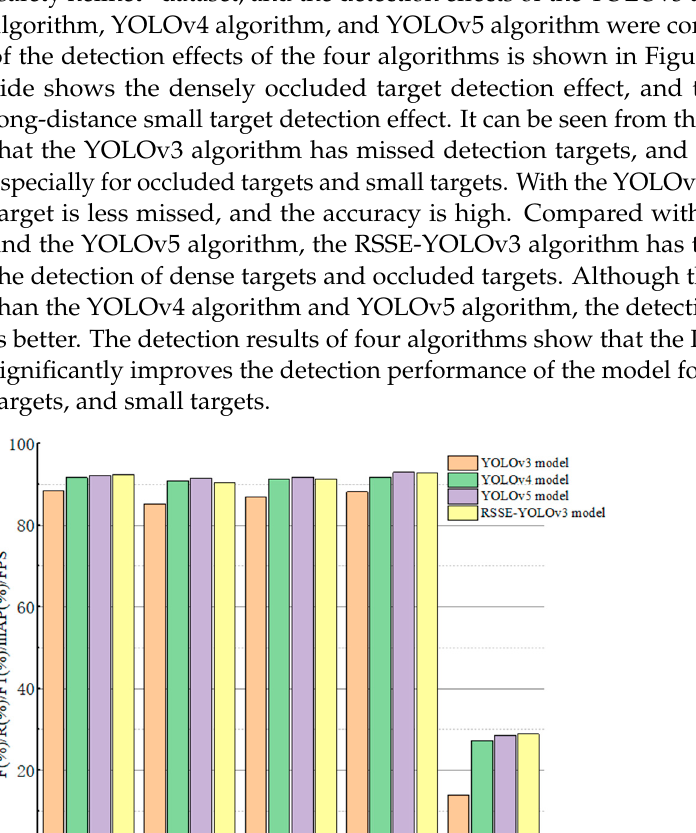
Table 5. Comparison of different algorithms for object detection.